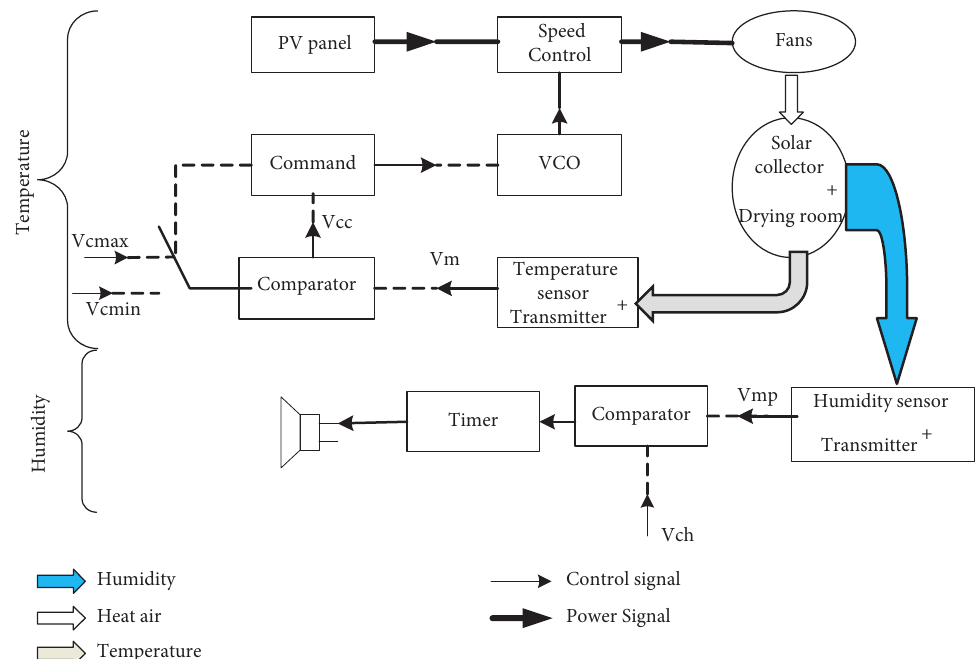
Figure 5: Diagram of electrical control of temperature and relative humidity.